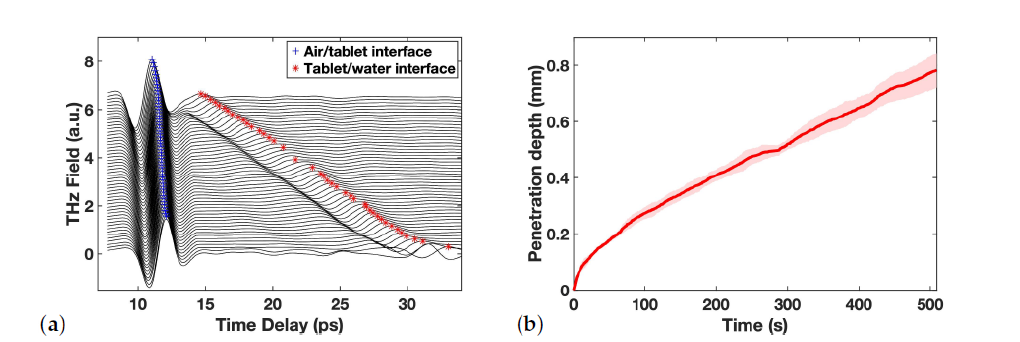
Figure 1. ( a ) An example of resulting TPI waveforms over time, with two interfaces tracked and marked. ( b ) Averaged penetration depth vs. time for a batch, errors illustrated as the shadowed